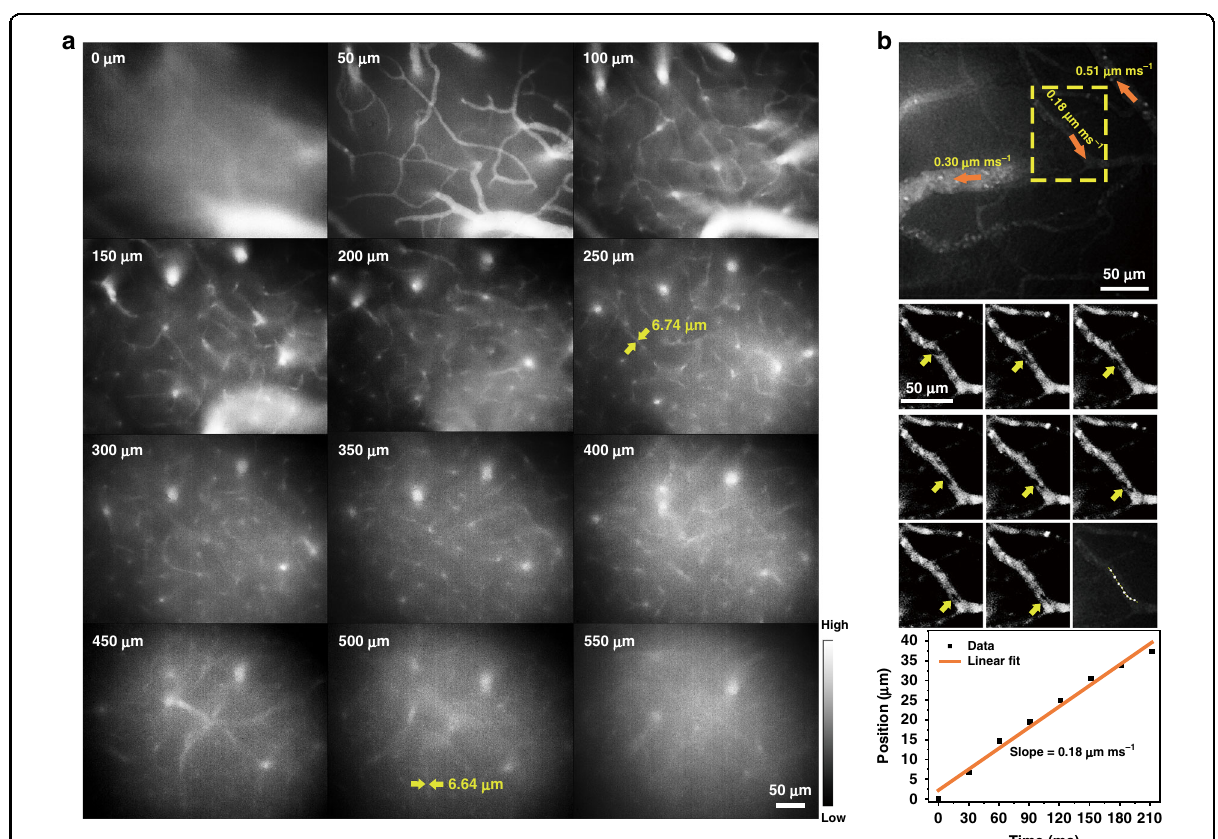
Fig. 4 The application of ICG ’ ASF in cerebral vascular tomography and fl ow velocity measurement. a In vivo ASF wide- fi eld microscopic images of brain blood vessels (at various depths from 0 μ m to 550 μ m) of the mouse injected with ICG (5 mg mL − 1 , 250 μ L). Excitation: 915 nm CW laser; fl uorescence collection range: 800 – 900 nm; exposure time: 25 ms. Scale bar: 50 μ m. b Flow velocity measurements of three sampled brain blood vessels. Orange arrows indicate the directions of blood fl ow. Frames of the yellow dashed box were recorded (middle in the right), showing the tracking of a dark spot in one cerebral vessel. A fi tting line (bottom in the right) revealing the position of the spot as a function of time is shown. The slope of the fi tting line stands for the blood fl ow velocity (0.18 μ m ms − 1 ) in this cerebral vessel. Excitation: 915 nm CW laser; fl uorescence collection range: 800 – 900 nm; exposure time: 30 ms. Scale bar: 50 μ